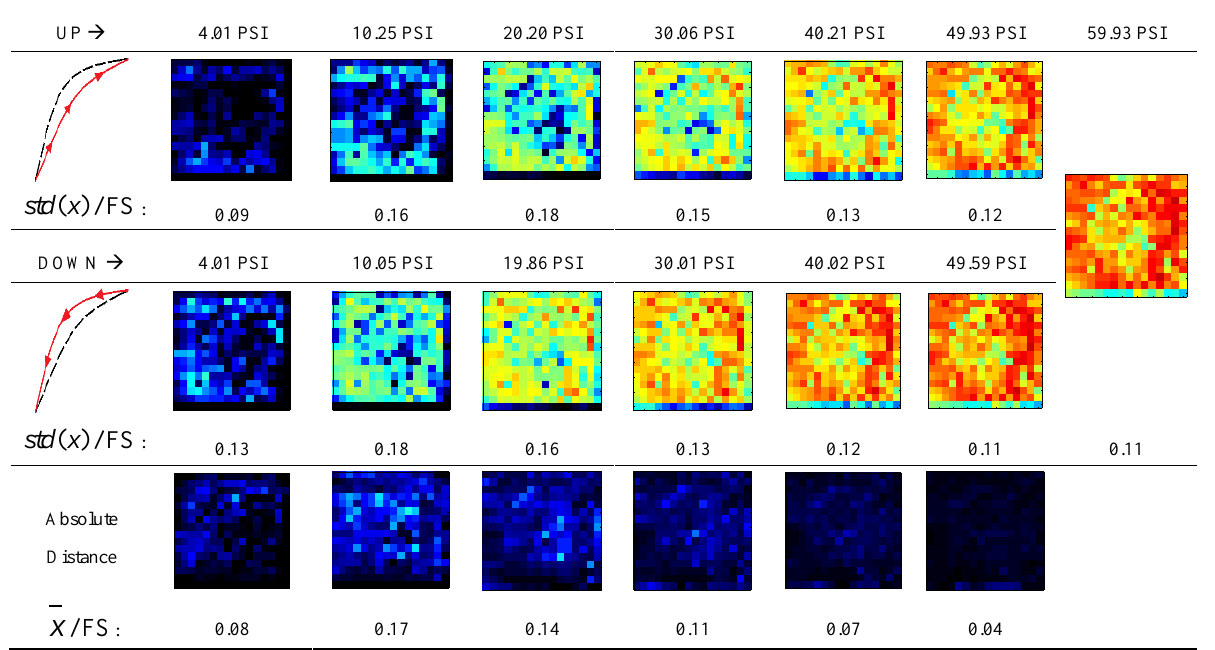
Table 6. Hysteresis loop frames measured before compensation.